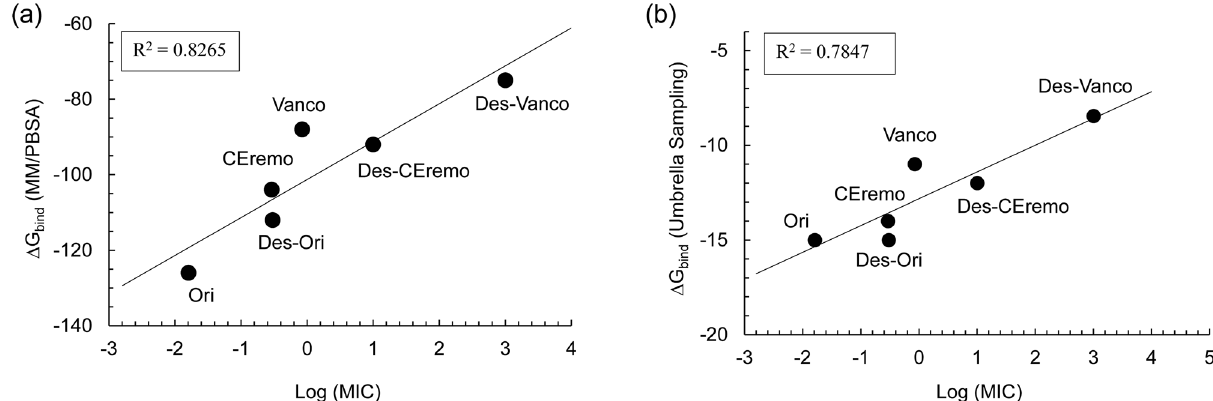
Figure 3. Plots of binding energy vs minimum inhibitory concentration for the (desleucyl)glycopeptide complexes. ( a ) Plots of MM/PBSA binding energy ( ΔG bind ) vs. Log (MIC). ( b ) Plots of umbrella sampling binding energy vs. Log (MIC).